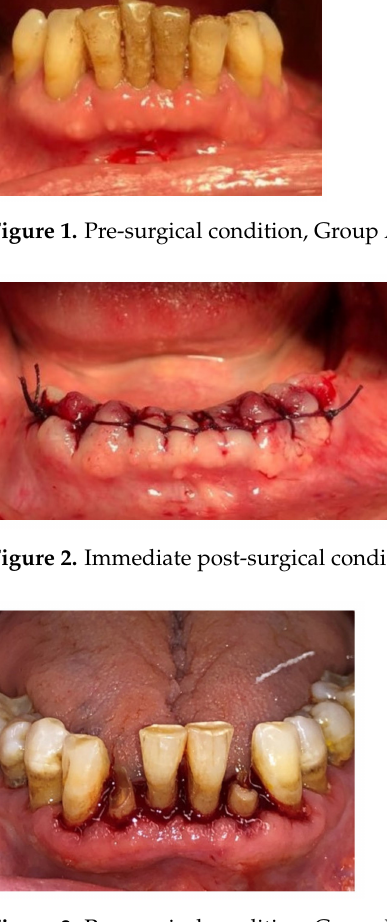
Figure 3. Pre-surgical condition, Group B.